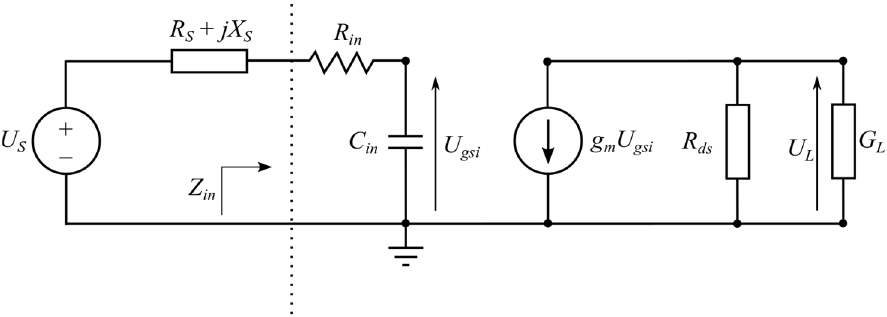
Figure 3. Simplified power amplifier model with GaN HEMT.